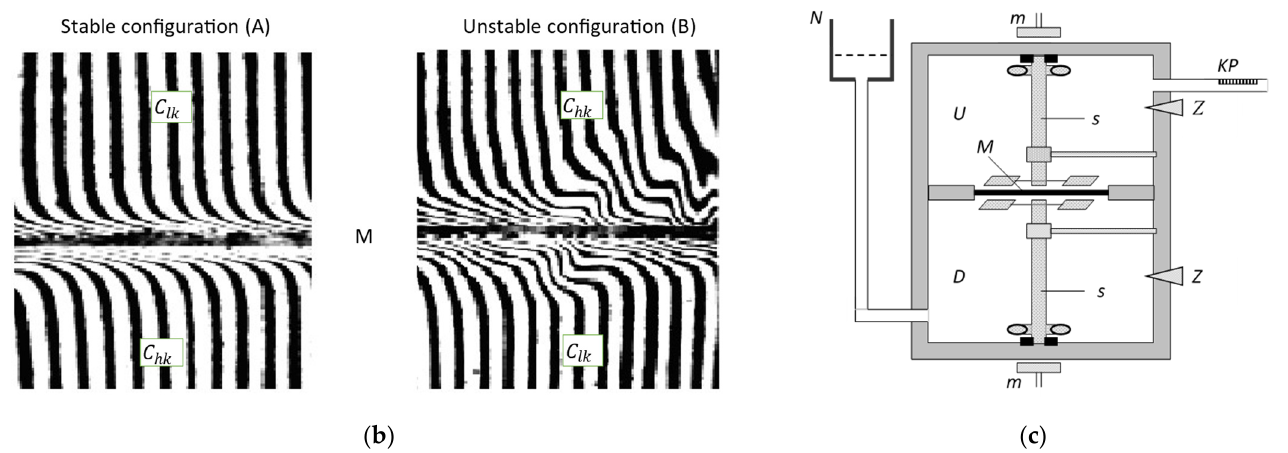
Figure 1. ( a ) Schematic representation of the single-membrane system in configuration A and B. M—membrane, g —gravitational acceleration, l A and l A —the concentration boundary layers in configuration A, l B and l B —the concentration boundary layers in configuration B, P h and P l —mechanical pressures, C hk and C lk —global solution concentrations ( C hk > C lk ), C A , C A , C B and C B —local (at boundaries between membrane and CBLs) solution concentrations, J A and J A v —solute and volume fluxes in configuration A, respectively, J B and J B v —solute and volume fluxes in configuration B, respectively, ( k = 1 or 2). ( b ) Interferograms for aqueous solution of glucose and ethanol for configurations A and B of a single-membrane system ( ∆ π 1 = 98.1 kPa and ∆ π 2 = 490.2 kPa), based on [32]. ( c ) Scheme of a measuring system ( U , D —measuring vessels, N —external solution reservoir, s —mechanical stirrers, M —membrane, KP —graduated pipette, m —magnets, z —stoppers)